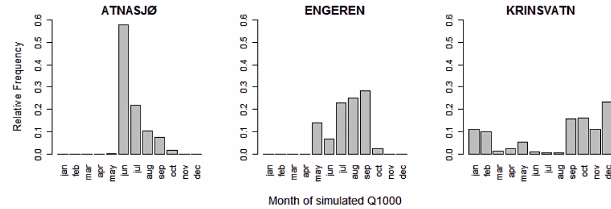
Figure 14. Relative frequency of the 10 4 simulated Q1000 events by